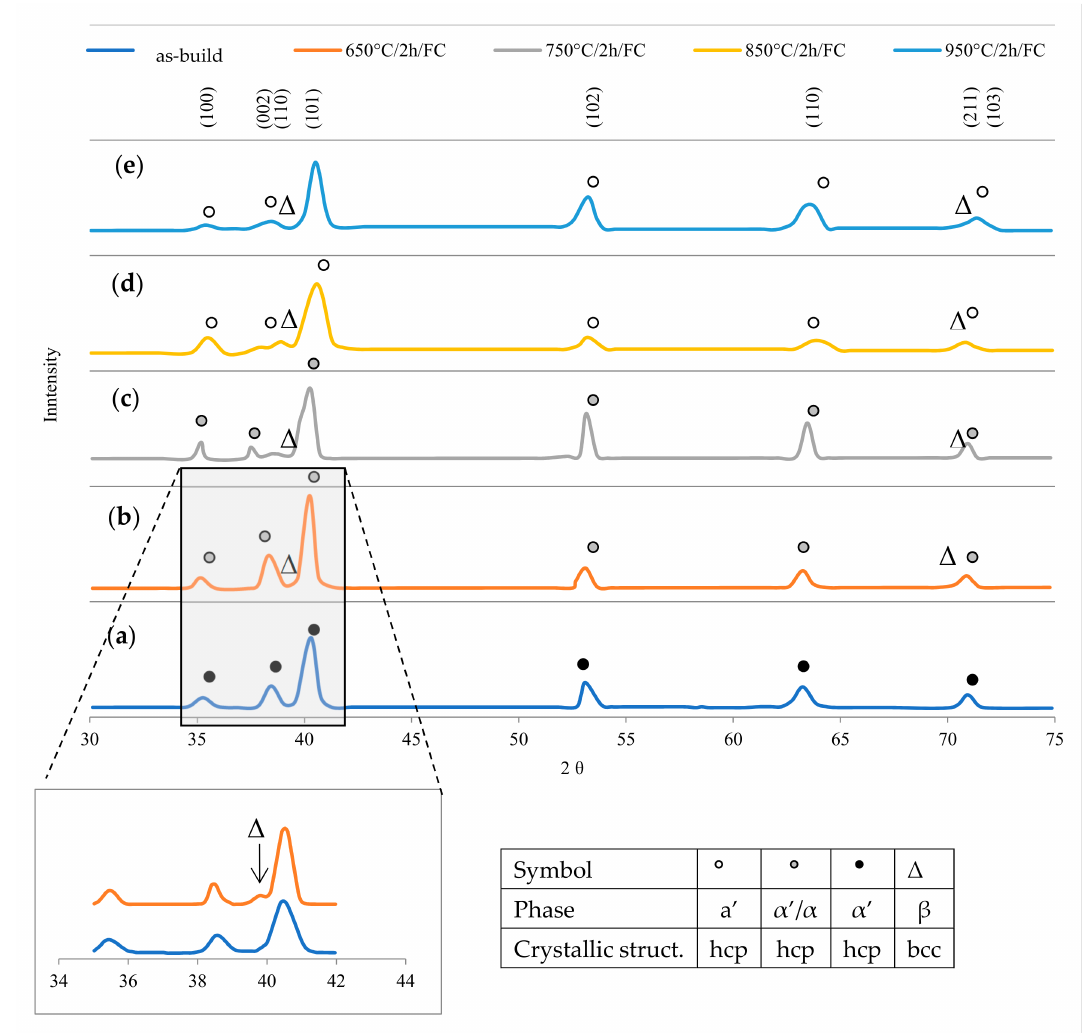
Figure 14. XRD spectrum of Ti6Al4V alloy DMLS: ( a ) as-build, ( b ) annealing at 650 ◦ C, ( c ) annealed at 750 ◦ C, ( d ) 850 ◦ C, and ( e ) 950 ◦ C for 2 h, cooled with a